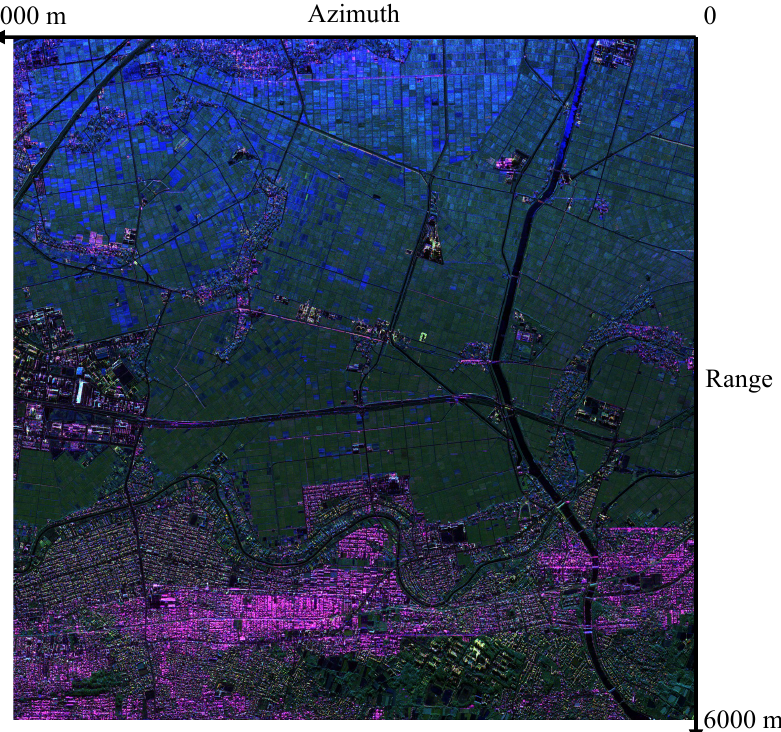
Figure 14. Another G4U image after calibration near Niigata Univ. on 25 August 2013 (Center: N37.852,